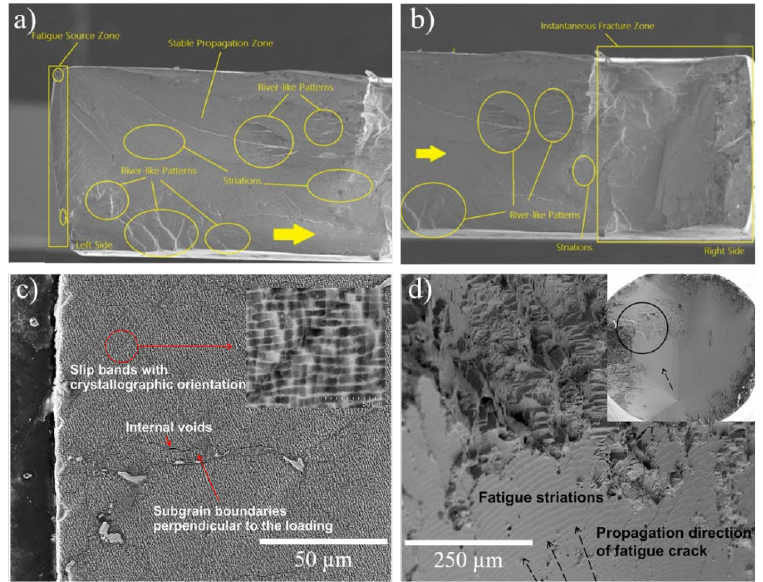
Figure 8. ( a , b ) Fracture surfaces of untreated and WLSP (3 layers) treated DD6 following tension- tension LCF tests. ( c , d ) Fracture surfaces of single crystal Ni-based superalloy following isothermal fatigue. Reprinted from [64,66] with permission from Springer and Elsevier respectively.